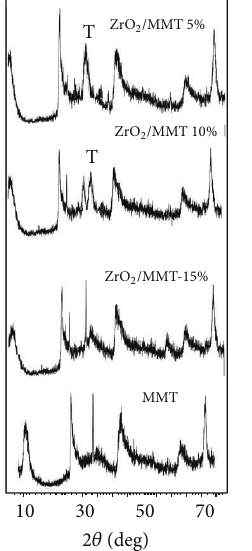
Figure 1: XRD pattern of ZrO 2 /MMT.